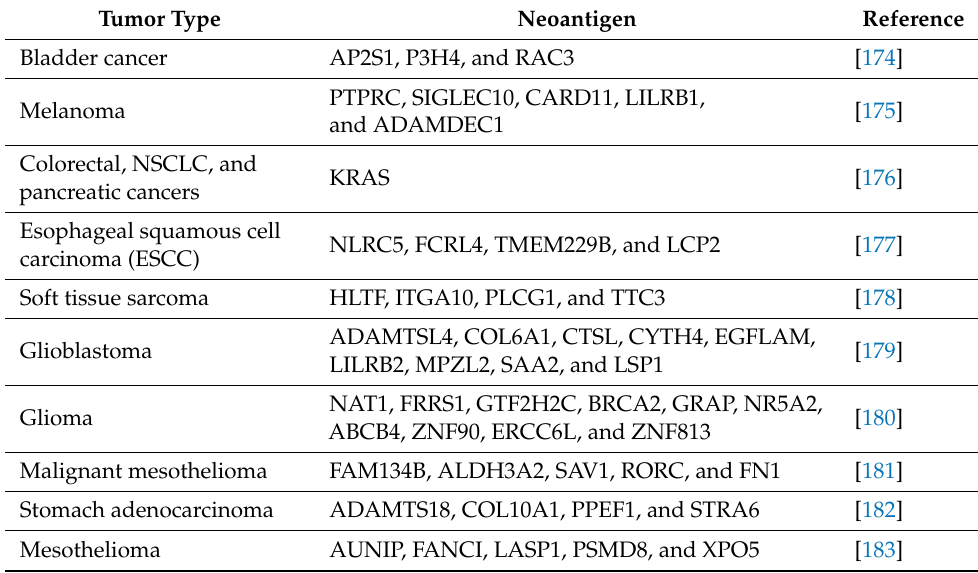
Table 4. Selected neoantigens for use in mRNA